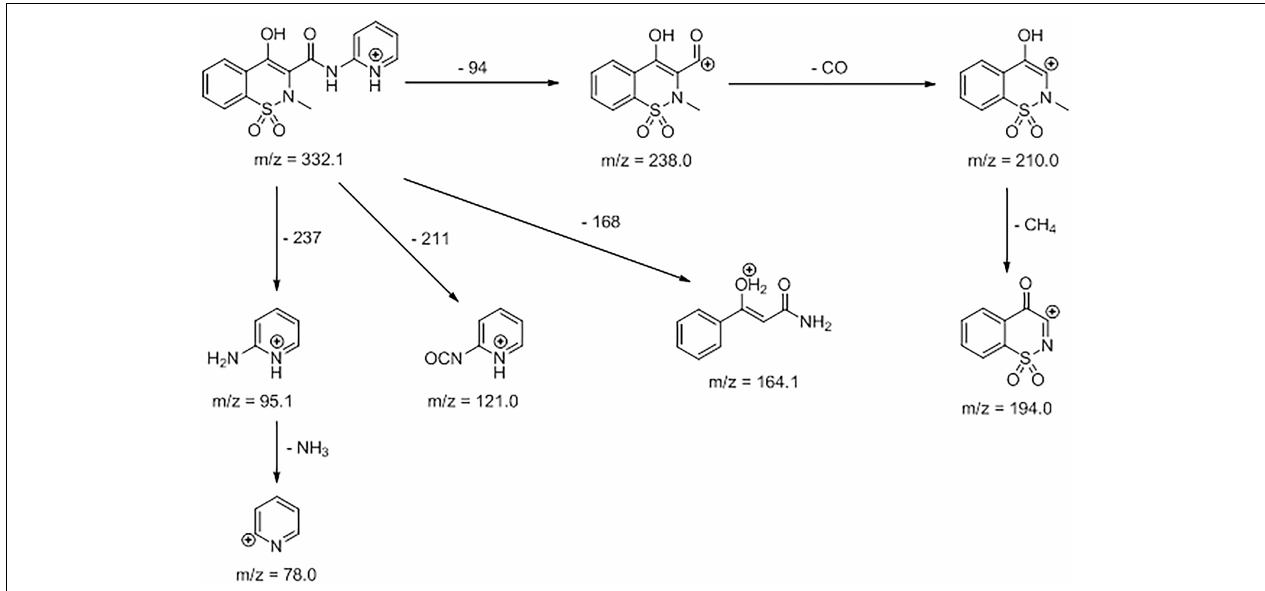
FIGURE 2 | Proposed fragmentation pattern of piroxicam by mycelium from in vitro cultures of L. edodes .